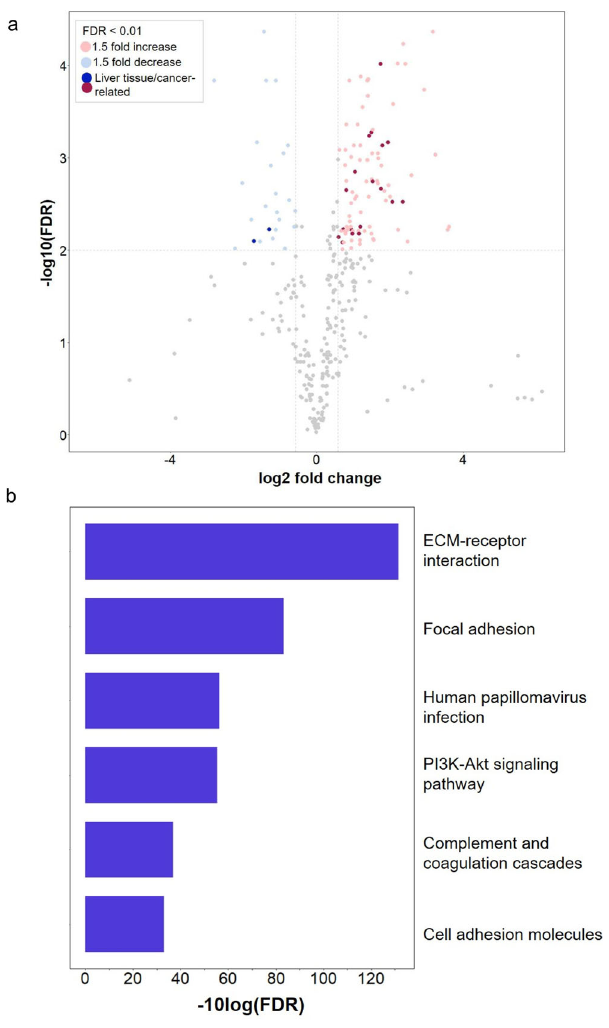
Fig. 5 Quantitative analysis of glycosites from HCC tumor (Tumor) and normal (Normal) tissues by TMT labeling coupled with the STAGE method. a Differential expression of glycosylation sites containing ≥ 1 CF sites between Tumor and Normal tissues. Glycosylation sites that were up- and down-regulated (FDR < 0.01 and fold change ≥ 1.5) in tumor relative to normal tissues are highlighted in pink and blue, respectively, of which glycosites from liver tissue/cancer-related glycoproteins are highlighted in darker colors. b KEGG pathway assignment based on upregulated proteins. Source data are provided as a Source Data fi